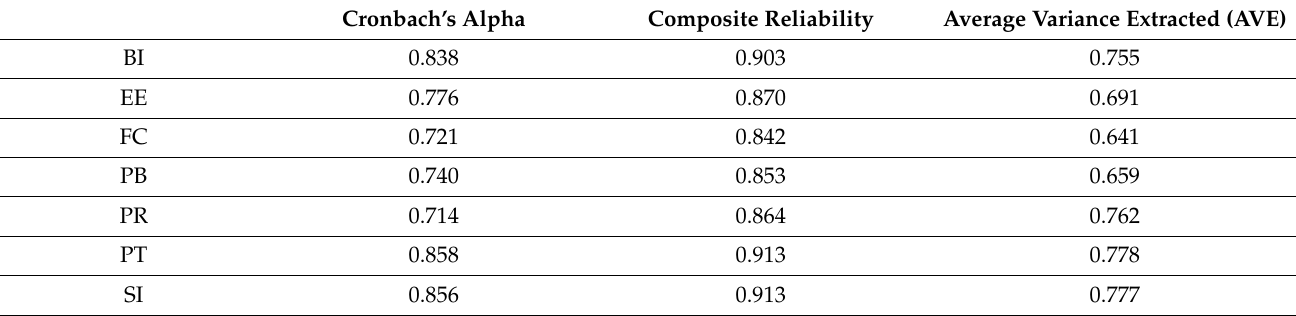
Table 3. Construct reliability and validity values.